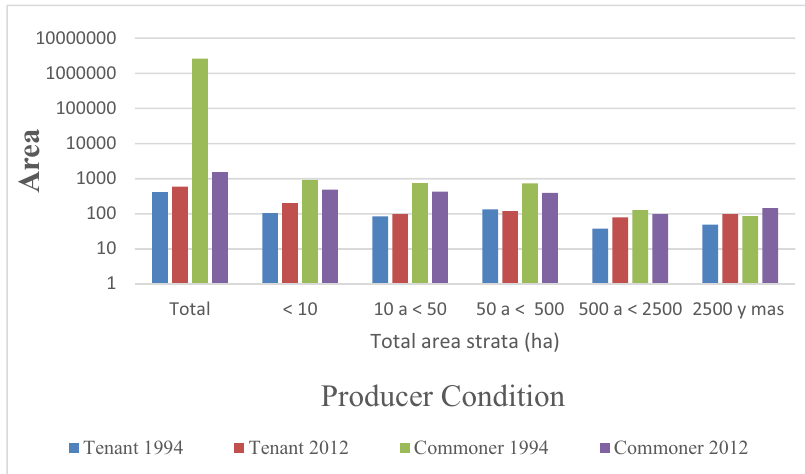
Figure 5: Area total of establishments in Peru by area strata managed by tenants and commoner in 1994 and 2012. Source: Own elaboration from ref. [ 51 ]